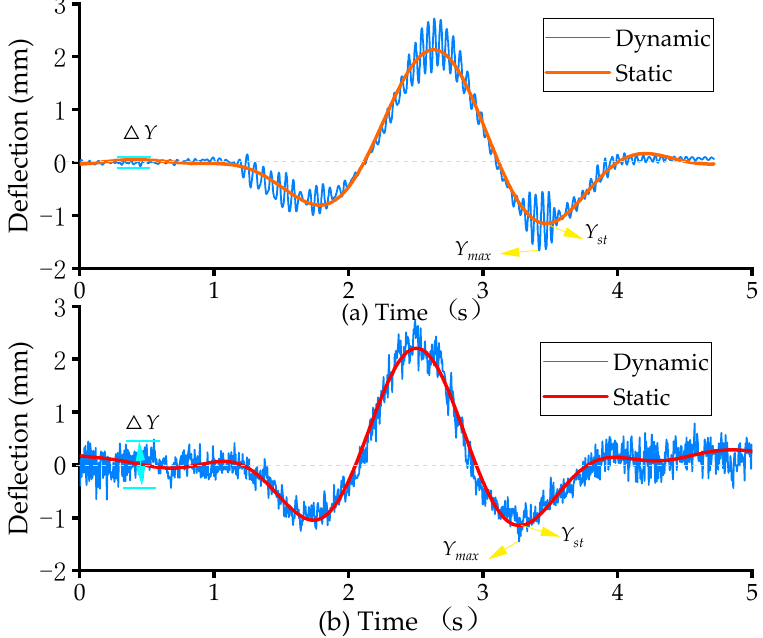
Figure 19. Deflections measured by different